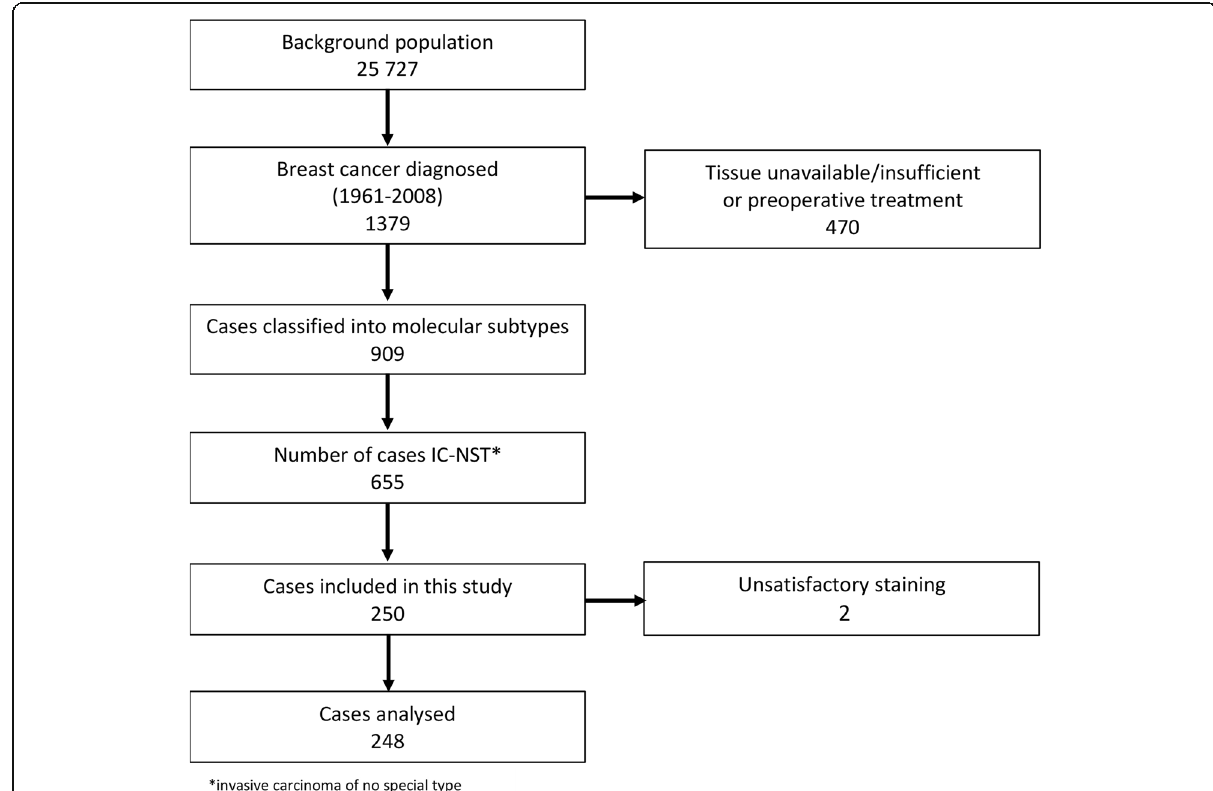
Fig. 1 Flowchart showing an overview of the cases included in this